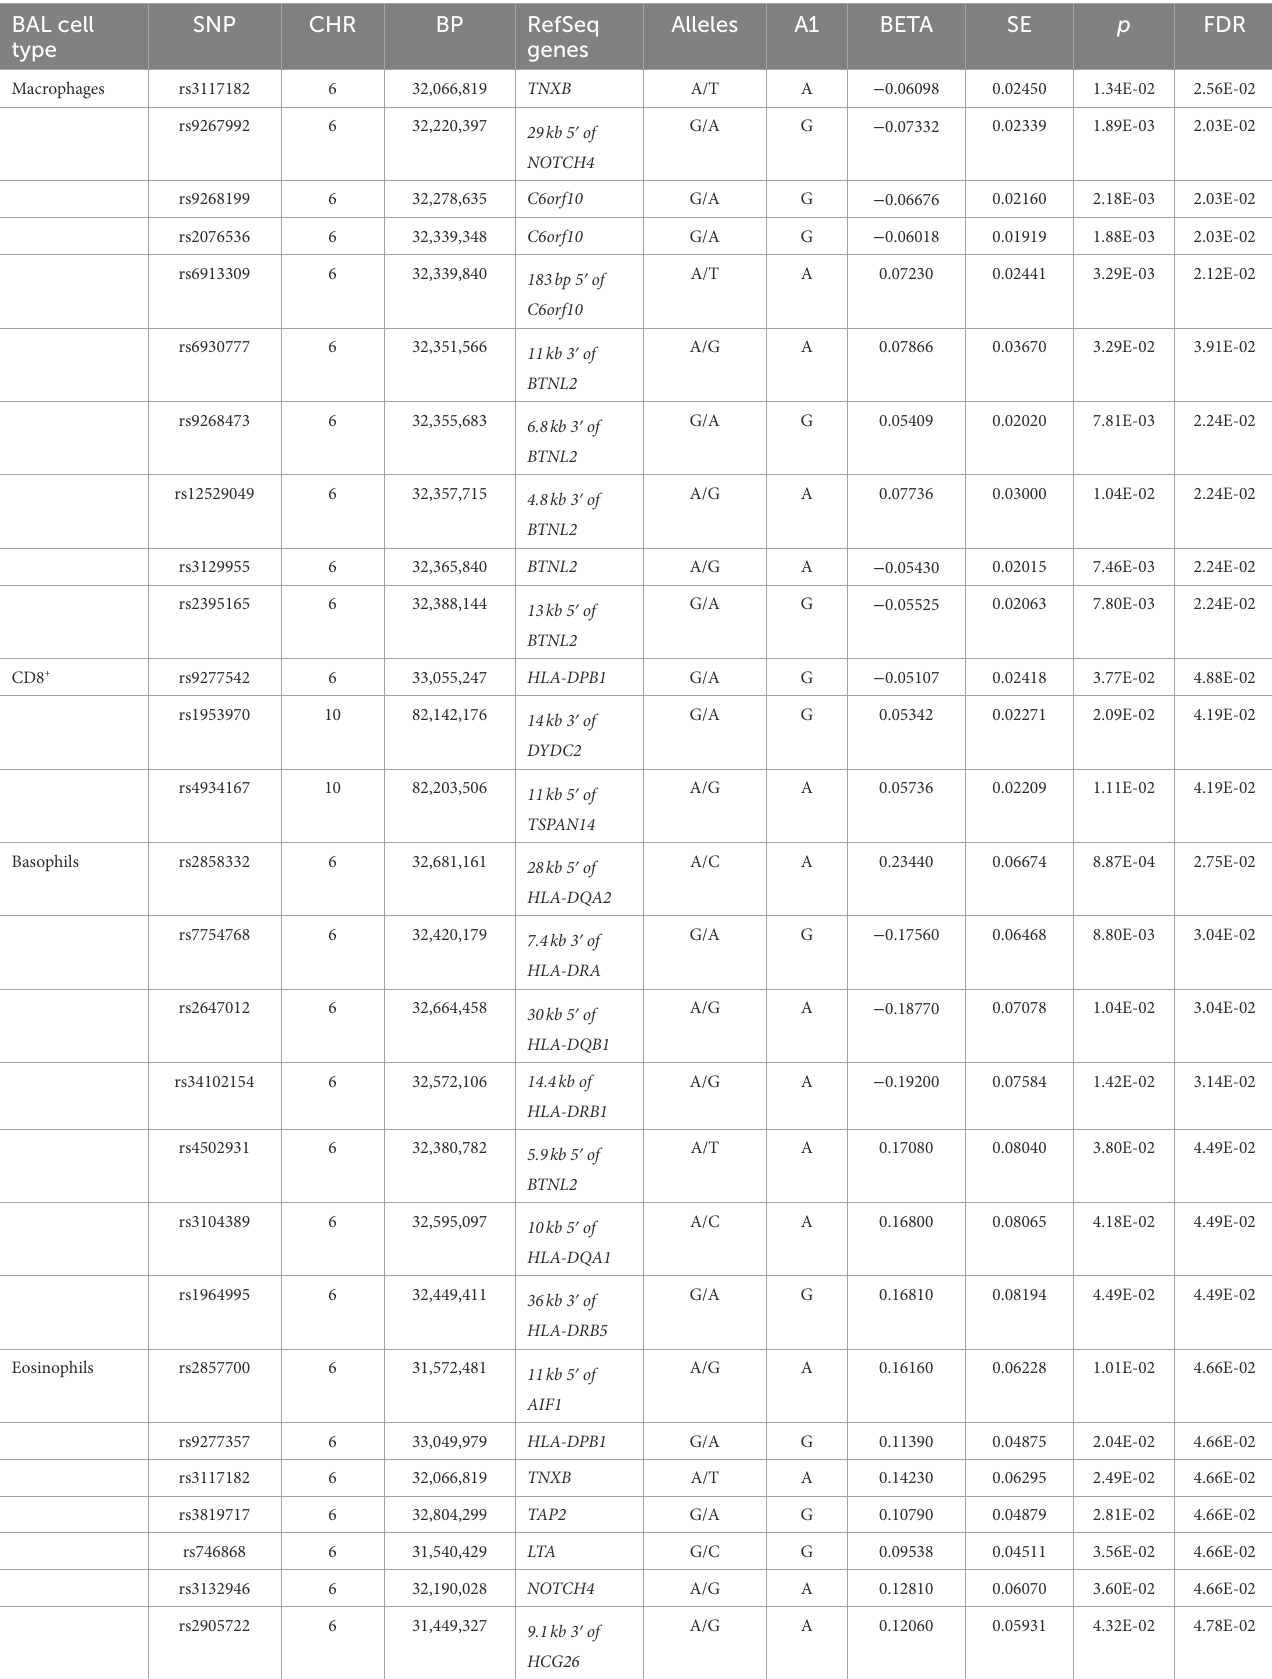
TABLE 3 Association results of non-LS BAL cell types (log10-transformed of quantitative levels). BAL cell